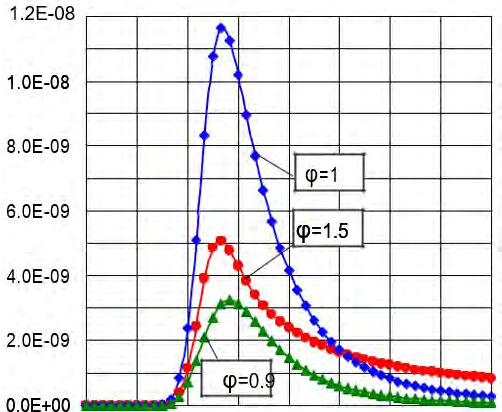
Figure 5. Sootconcentration vs crank angle with different equivalence ratios (D15, n=2400rpm)